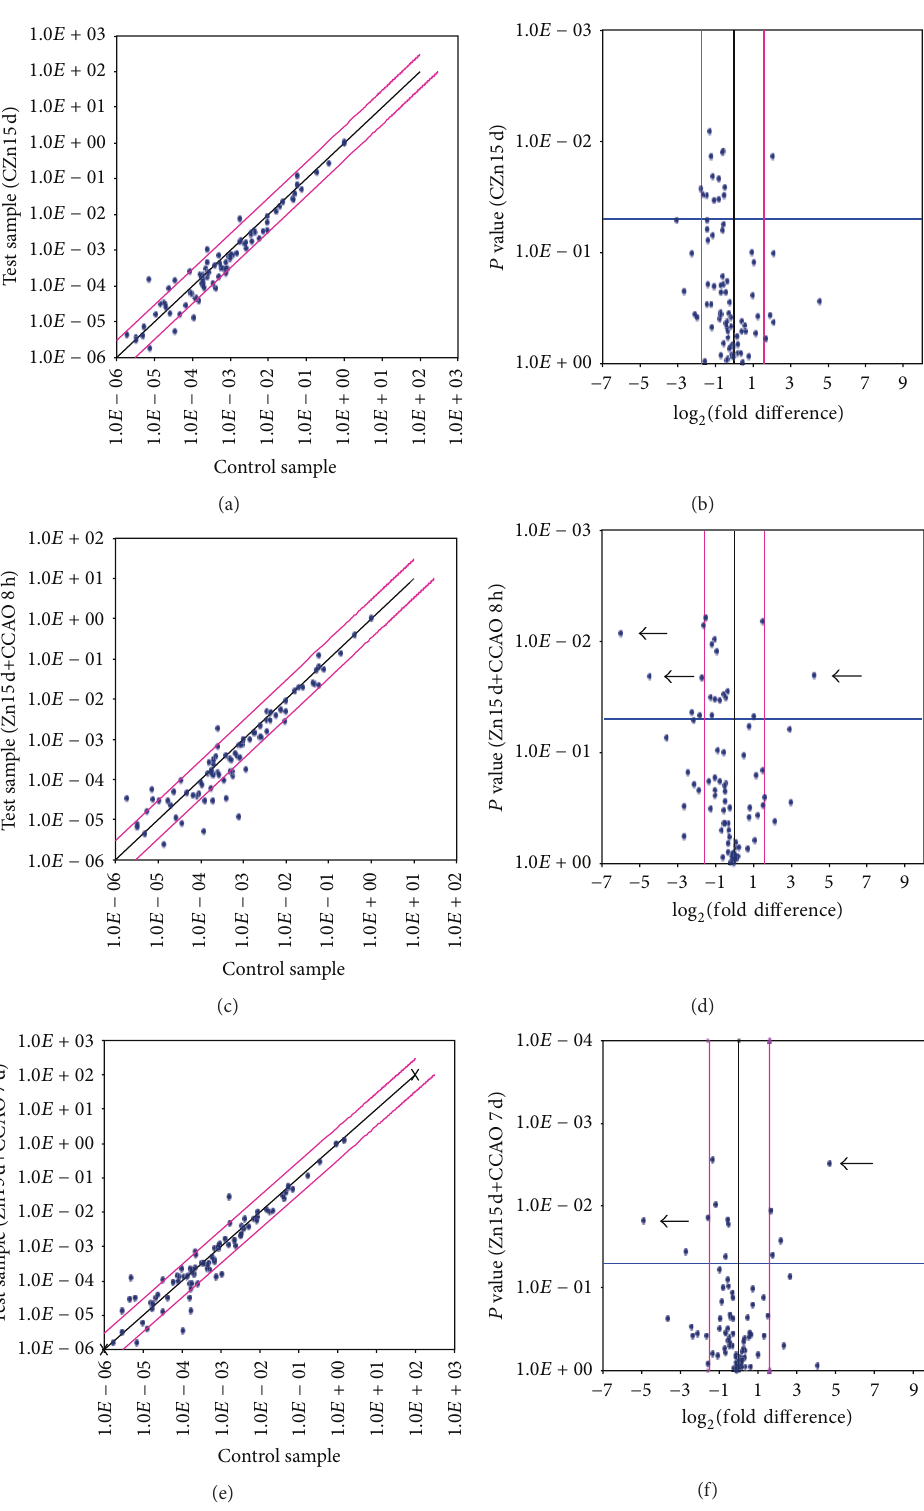
Figure 2: Overview of scatter and volcano plot of expression of 84 genes in temporoparietal cortex-hippocampus using RT 2 Profiler PCR array.((a)and(b))Ratswithchronicadministrationofzinc(CZn15 d).((c)and(d))RatswithchronicadministrationofzincbeforeCCAOand evaluations at 8h after reperfusion (Zn15d+CCAO 8 h). ((e) and (f)) Rats with chronic administration of zinc before CCAO and evaluations at 7 days after reperfusion (Zn15d+CCAO 7 d). The experimental values were compared with those of untreated rats. The black line indicates fold changes [2 (−Δ Ct ) ] for scatter plot ((a), (c), and (e)) and log 2 (fold difference against 𝑃 value) in the volcano plot ((b), (d), and (f)). The pink lines indicate the desired fold change in gene expression threshold. Each value represents the mean of 3 independent experiments. Arrow shows values with high